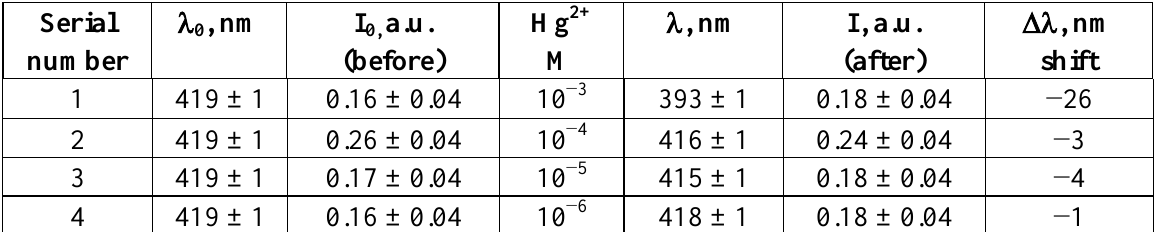
Table 1. The wavelength for the absorption maximum (nm) and absorption intensity (a.u.) for the polymer-dye film based on PVC before (  Hg(ClO ) solutions. 4 2